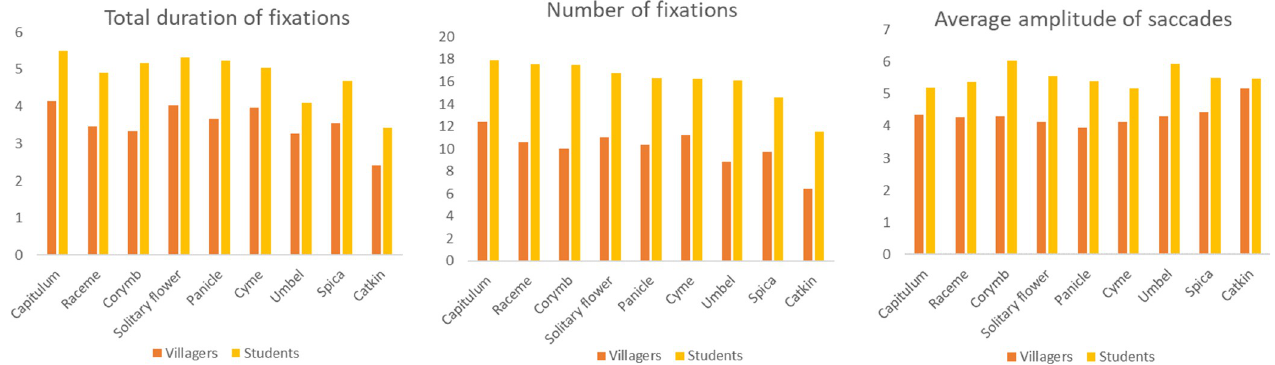
Fig 6. The average of eye movement indicators of different inflorescences by villagers and students.